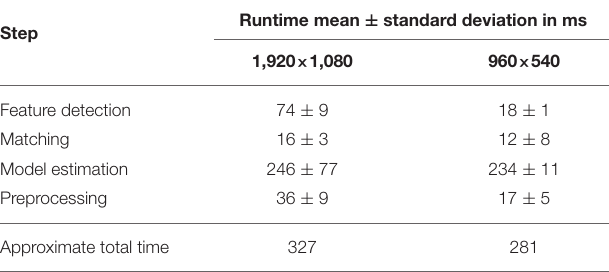
TABLE 2 | Results of performance evaluation.